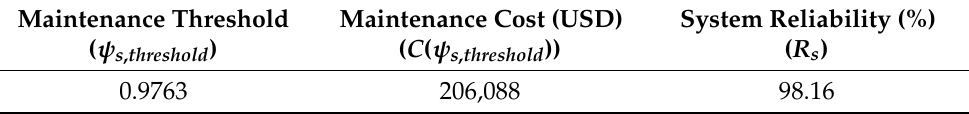
Table 7. The parameters and maintenance cost of the offshore wind system.